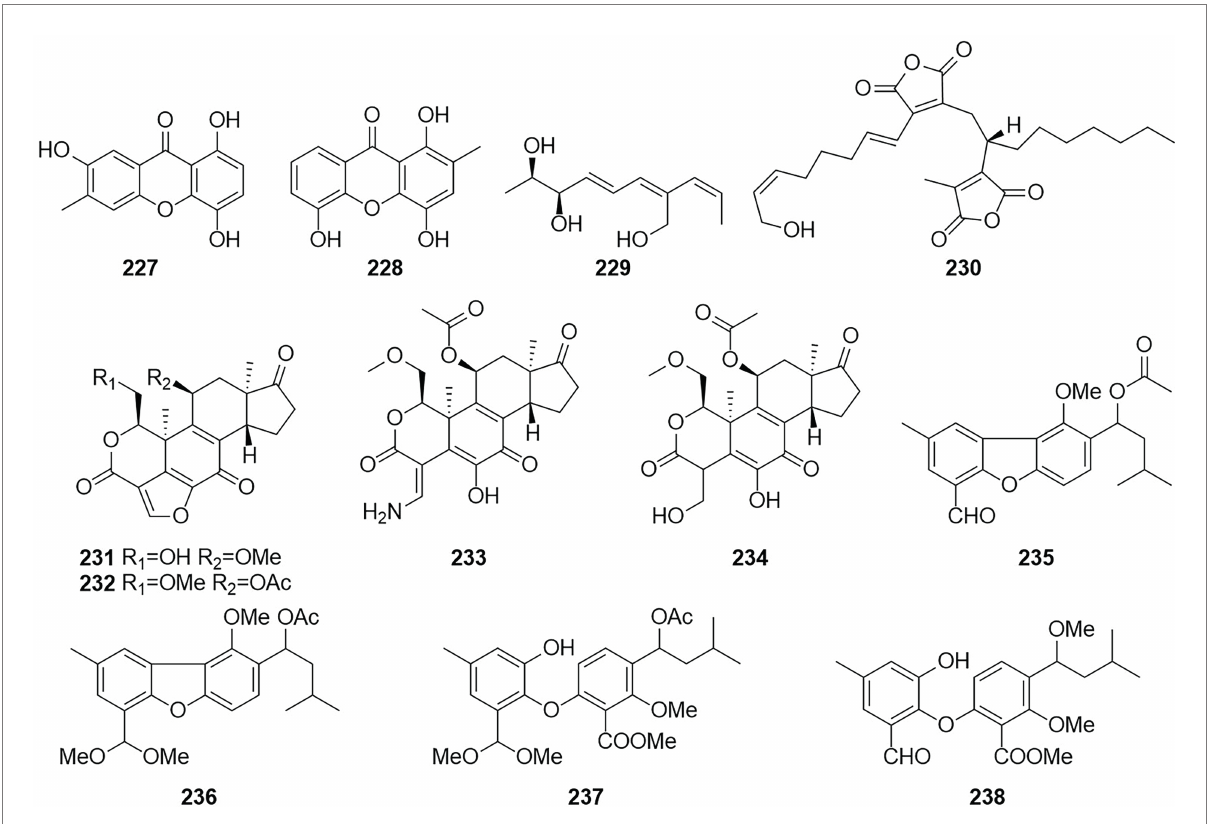
FIGURE 15 Chemical structures of compounds 227–238